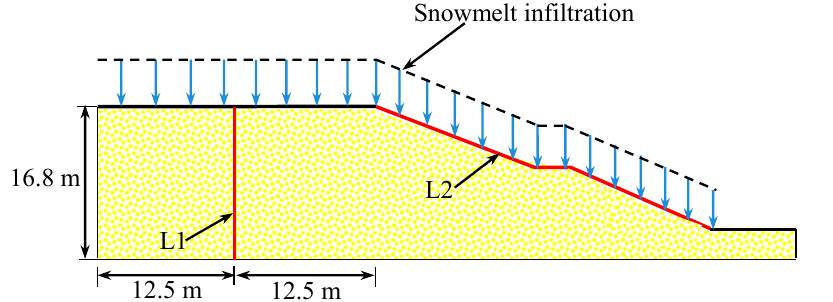
= 48 h; ( b ) t = 72 h; and ( c ) t = 96 h.